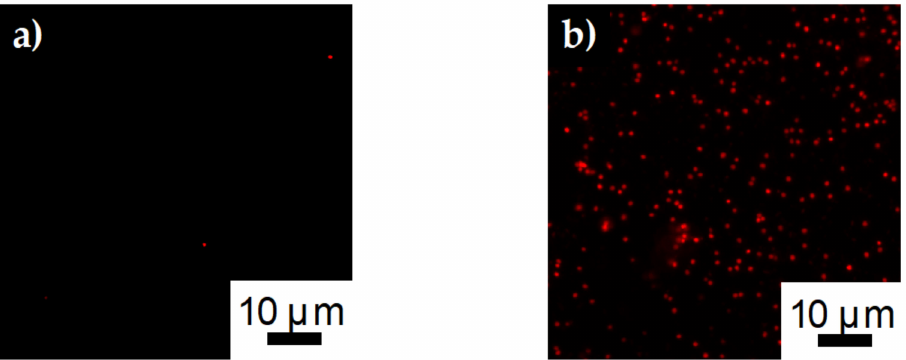
Figure 12. Confocal images of E. coli capture on a ) SDCNF mats and b ) ASSF mats at 3 × 10 7 inlet solution